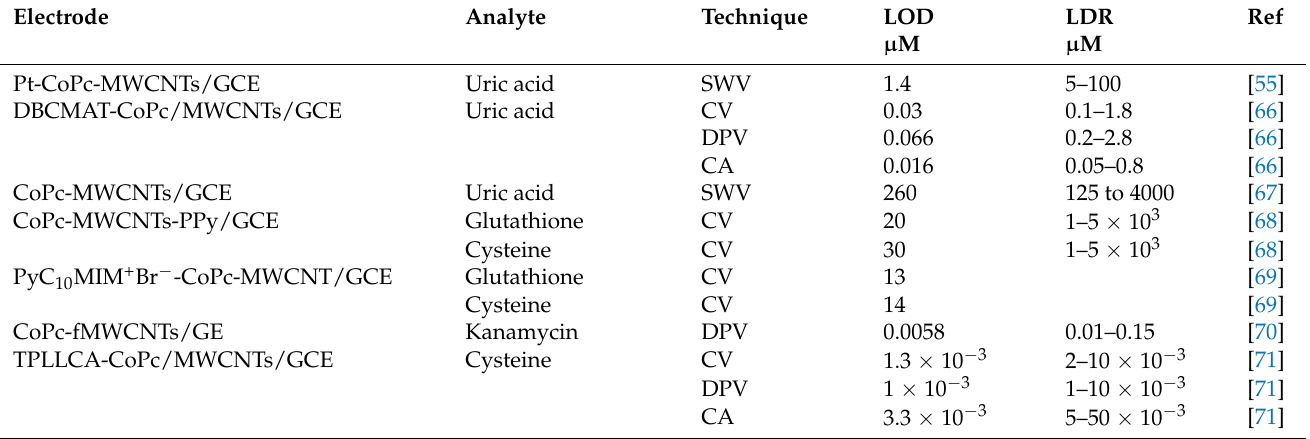
Table 4. Detection of cysteine, glutathione, uric acid, and kanamycin with CoPc-MWCNT-modified